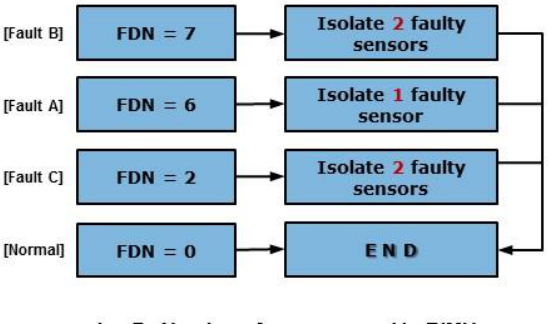
Figure 3. Fault isolation according to the